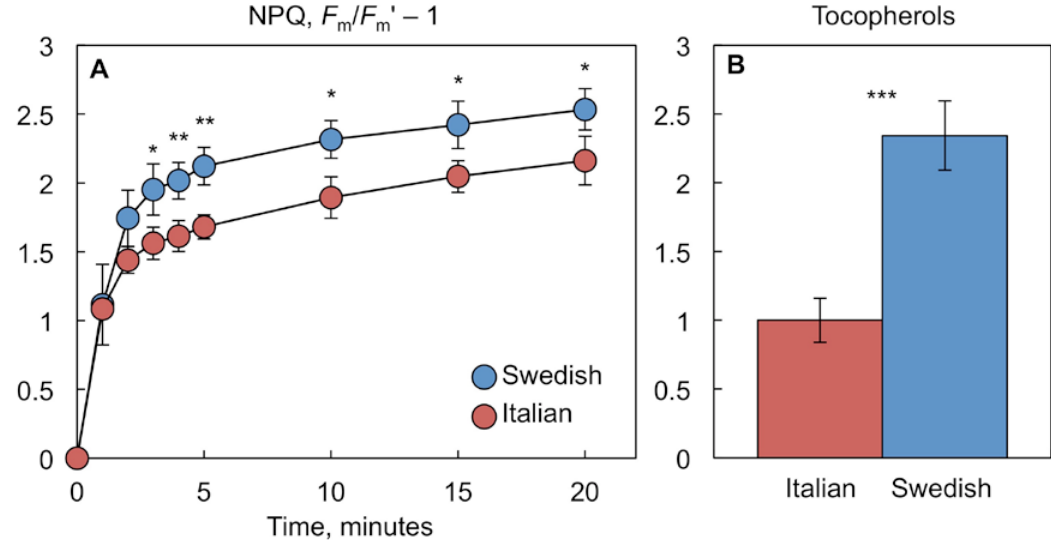
Figure 4. ( A ) Time course of the development of the non-photochemical quenching of chlorophyll fluorescence (NPQ) under 2% O 2 (balance N 2 ) and 2000 µmol photons m –2 s –1 at 25 °C and ( B ) tocopherol content for leaves of Italian (red symbols) and Swedish (blue symbols) ecotypes of Arabidopsis thaliana grown at 35 °C. Tocopherols are recalculated from data in Stewart et al. [8] and expressed as relative values (with the mean value for the Italian ecotype set to 1). Mean values ± standard deviations ( n = 3 or 4). Significant differences (Student’s t -test) between the ecotypes are indicated by asterisks; * = p < 0.05, ** = p < 0.01, *** = p < 0.001.